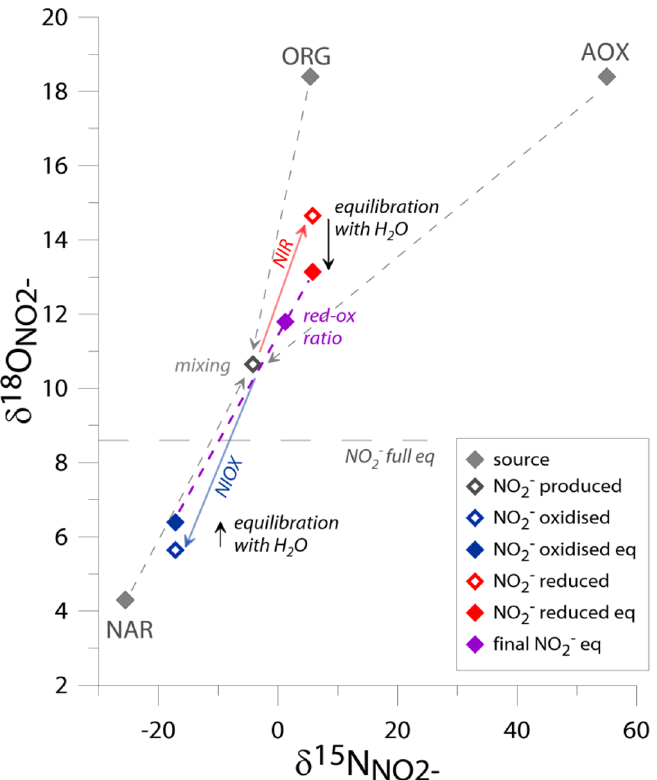
Figure 2. General scheme of the NO 2 − stable isotope model. The isotopic signatures of NO 2 − sources shown are based on the measured mean isotopic signatures of substrates for L1 and L2 and the isotopic fractionation associated with NAR, AOX and ORG (Table 1). Dashed gray arrows illustrate the mixing of 3 NO 2− sources with mean mixing proportions found in Ntrace study ( f NAR = 0.55, f AOX = 0.15, f ORG = 0.30, Table 1) resulting in the produced δ NO2 - (grey open point). This δ value can be modified by NIR (red arrow) and NIOX (blue arrow). The δ 18 O NO2 - after reduction or oxidation (red and blue open point, respectively) is further modified by equilibration with ambient water with the extent of 0.25 of the equilibrated oxygen atoms (red and blue filled point, respectively). The ratio of NO 2 - reduction and oxidation processes (red-ox ratio, here 4:1, as mean from Ntrace study, Table 1) determines the final δ NO2 - (purple